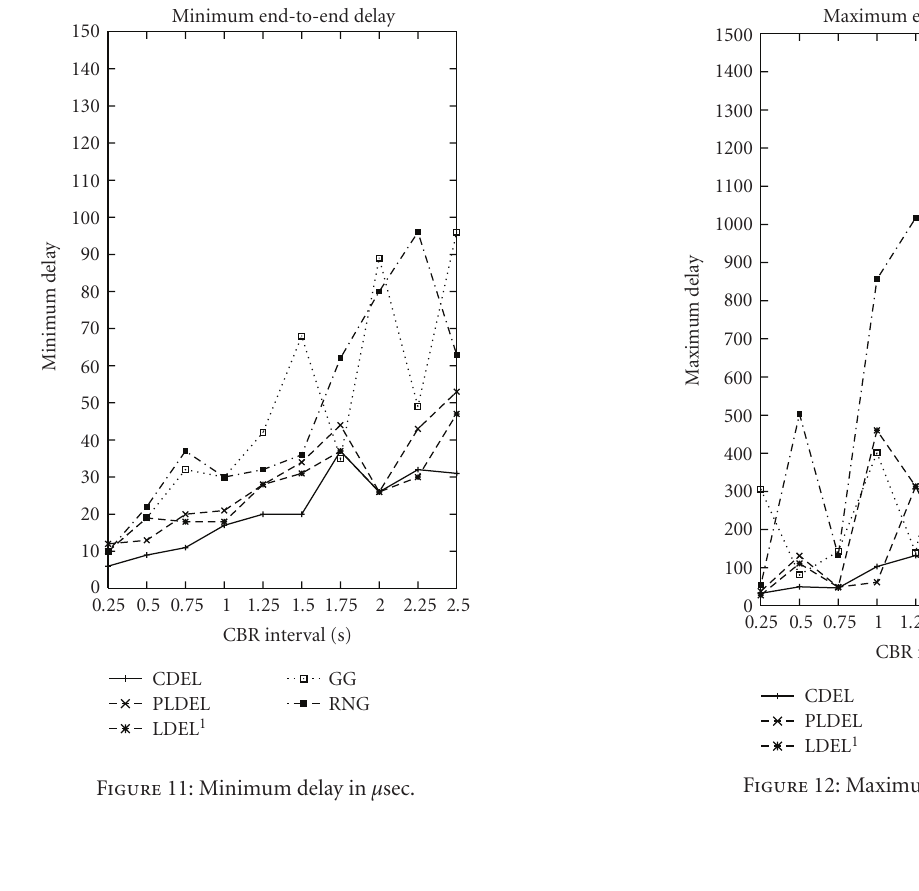
Table 2: Delivery ratios.